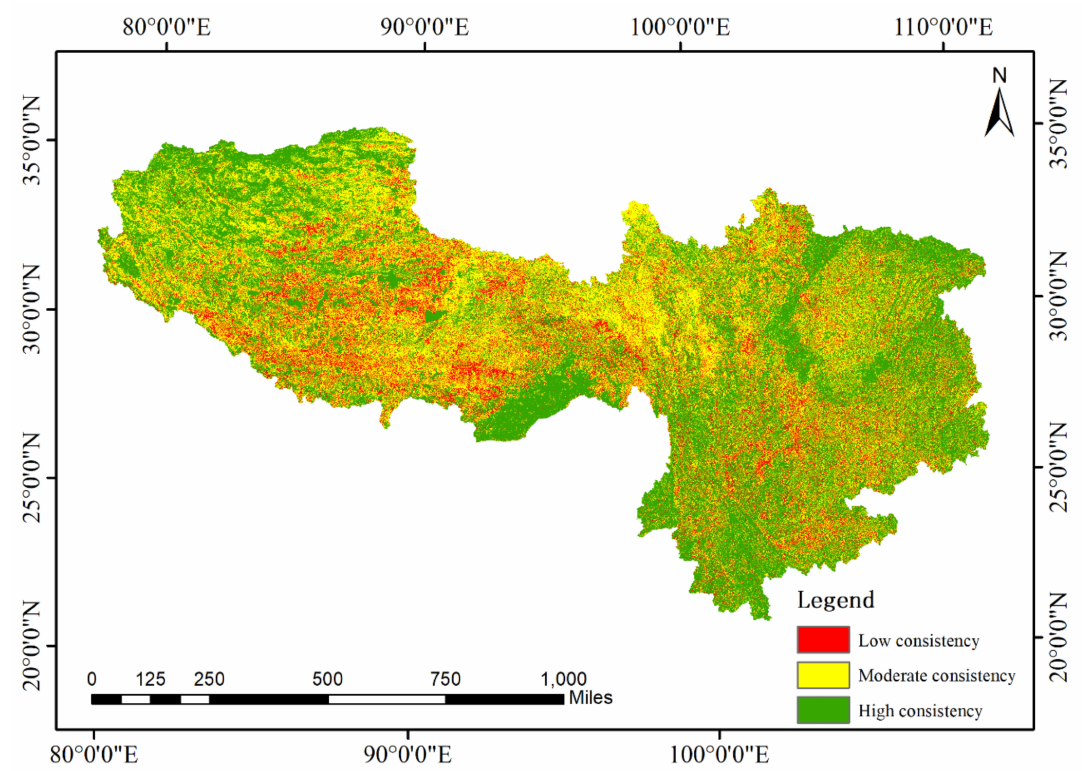
Figure 7. Spatial consistency distribution map of all land cover types in the study